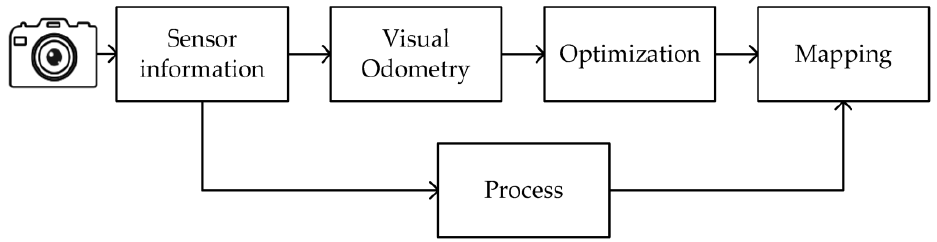
Figure 1. A typical framework of a visual SLAM system.